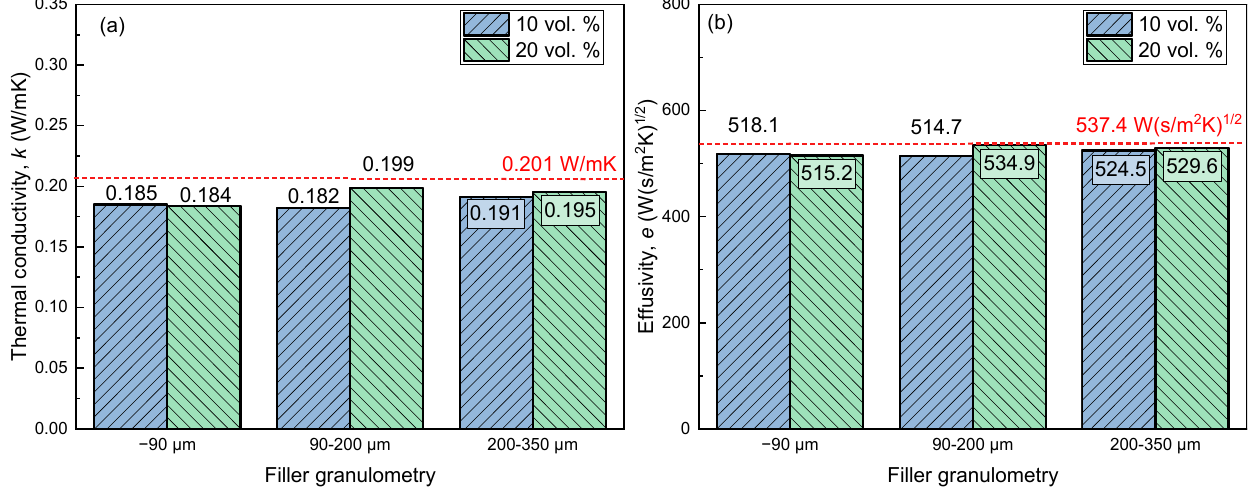
Figure 11. Thermal conductivity ( a ) and effusivity ( b ) of dogbone samples printed using composite filament (bars) and filament made of neat ABS (red dashed lines).